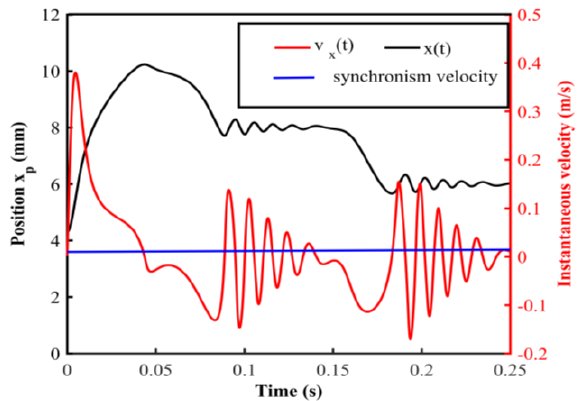
Figure 5. Evolution of the particle position x p ( t ) and its instantaneous displacement velocity v x ( t ) as a function of time at 5 Hz. Conditions: V = 1000 V, d p = 60 µ m, q p =10% q ps , x 0 = 4.3 mm, t = 250 ms.